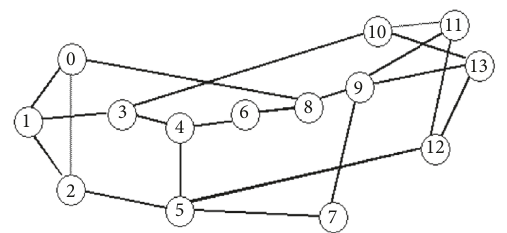
Figure 19: 14 node NSFNET topology.